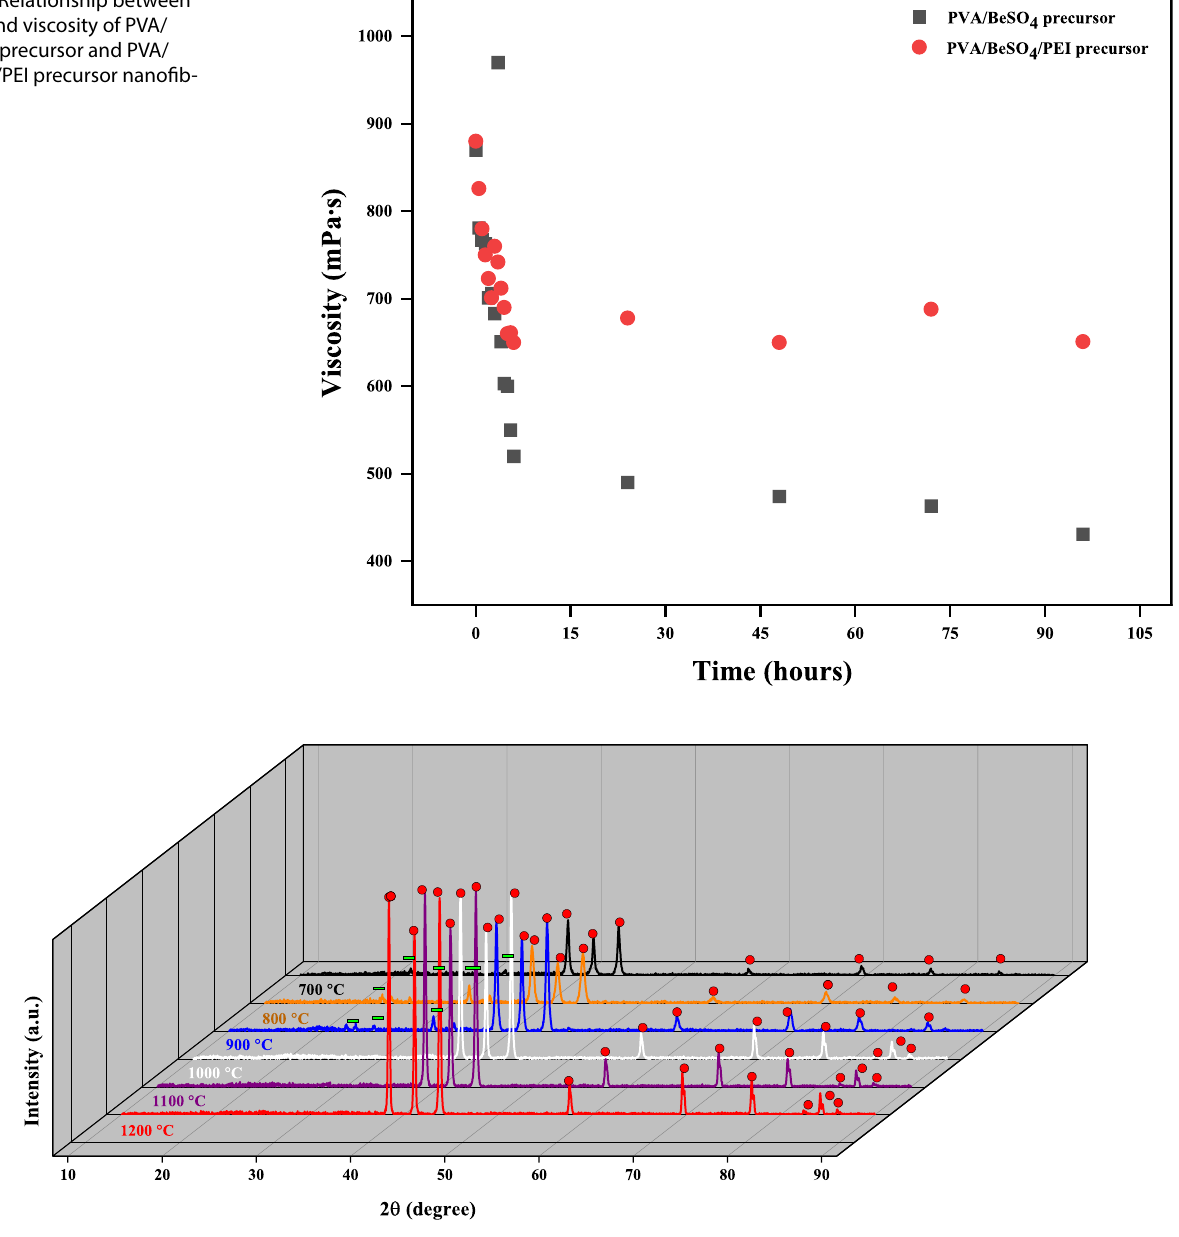
Fig. 5 XRD curves of BeO nanofibers ( : BeO, : other than BeO